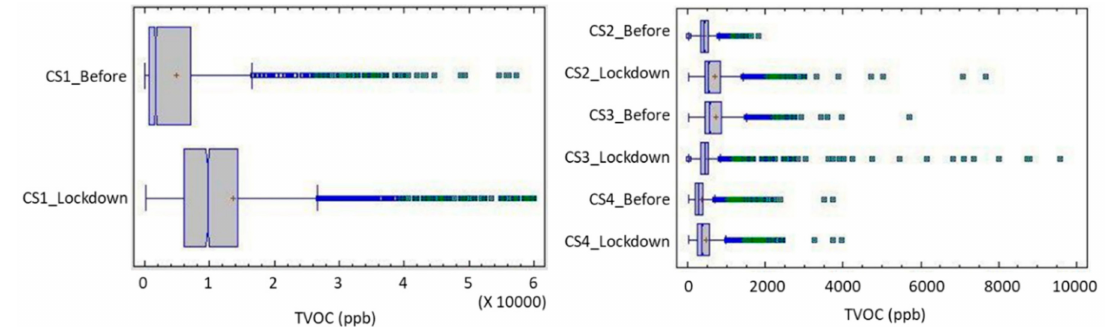
Figure 13. Box and whisker plot of the TVOC concentration for the case studies before and during the COVID-19 lockdown in